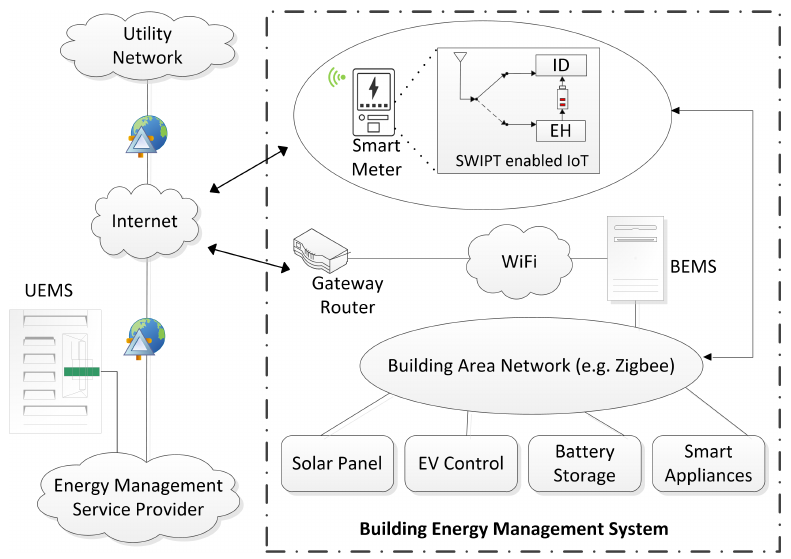
Figure 2. BEMS with IoT enabled PS-SWIPT, where smart meter in smart grid communication network exchange information between utility and